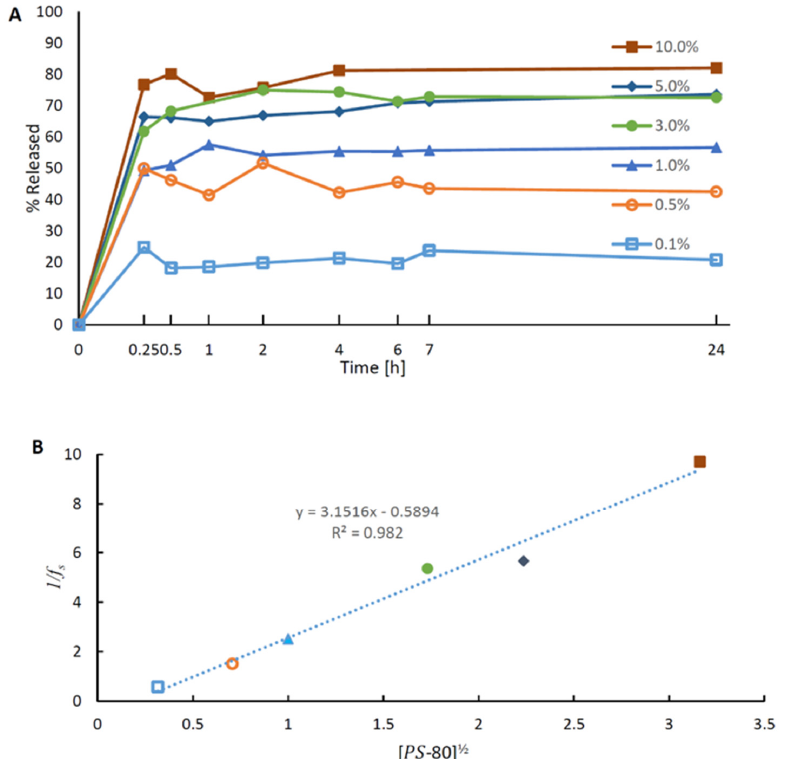
Figure 2. CBD release profiles from cetyl alcohol-stabilized nanoparticles: ( A ) release at various concentrations of polysorbate 80 in PBS solution; and ( B ) relationship between the reciprocal of the fraction of the precipitated CBD after 24 h and the square root ( a = 2) of polysorbate concentrations (according to Equation (5)).